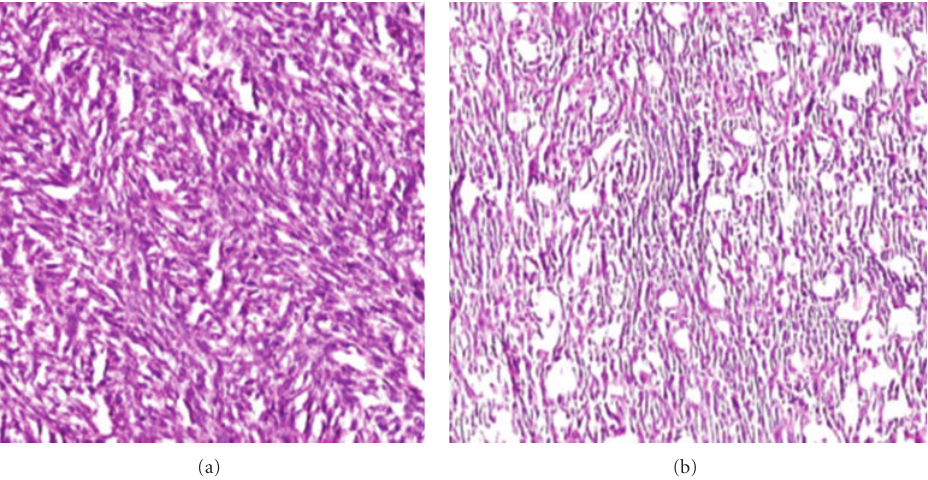
Figure 3: Photomicrographs showing the spindle cell (a) and the epithelial components (b) of the neoplasm ( × 100, H&E).